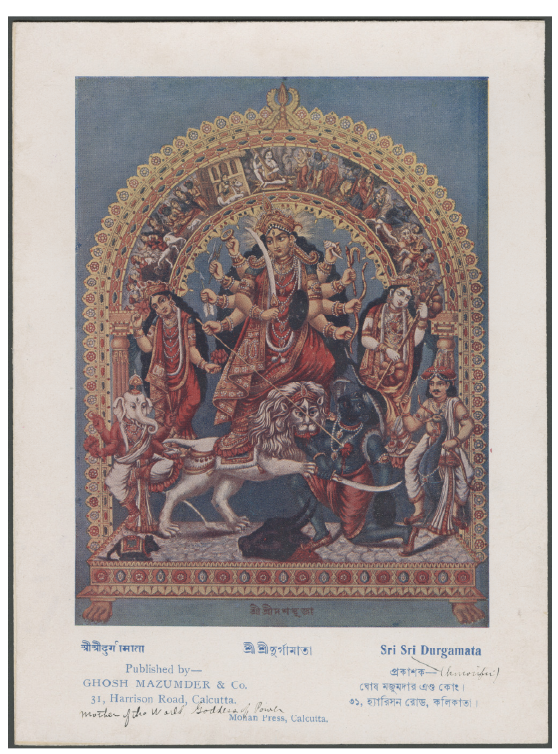
Figure 1. Sri Sri Durgamata